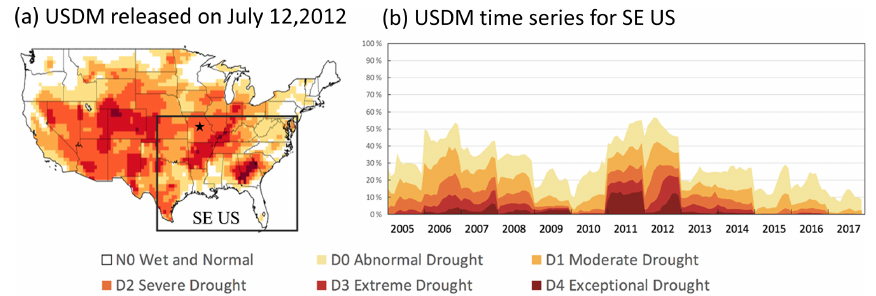
Figure 1. (a) Drought distribution for the second week of July 2012 based on the USDM. The black star indicates the location of the MOFLUX site. (b) Time series of drought frequency in the study area (black box in Fig. 1a) for JJA from 2005 to 2017. The color-coded drought conditions are as follows: N0 (white) for wet and normal, D0 (light yellow) for abnormal drought, D1 (yellow) for moderate drought, D2 (orange) for severe drought, D3 (red) for extreme drought, and D4 (brown) for exceptional drought.